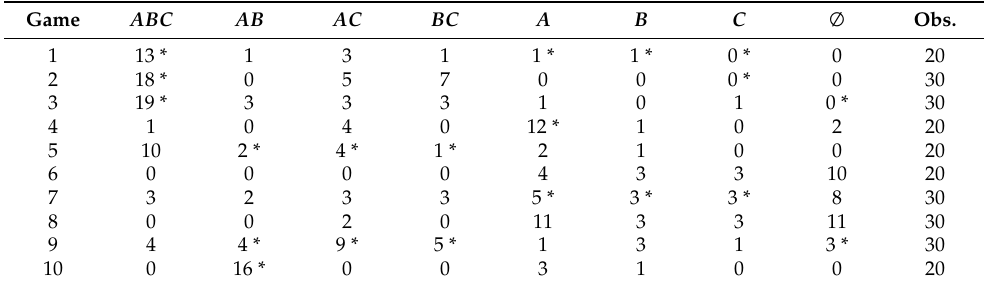
Table 2. Coalition formation in SIM, * corresponds to the NE outcome.